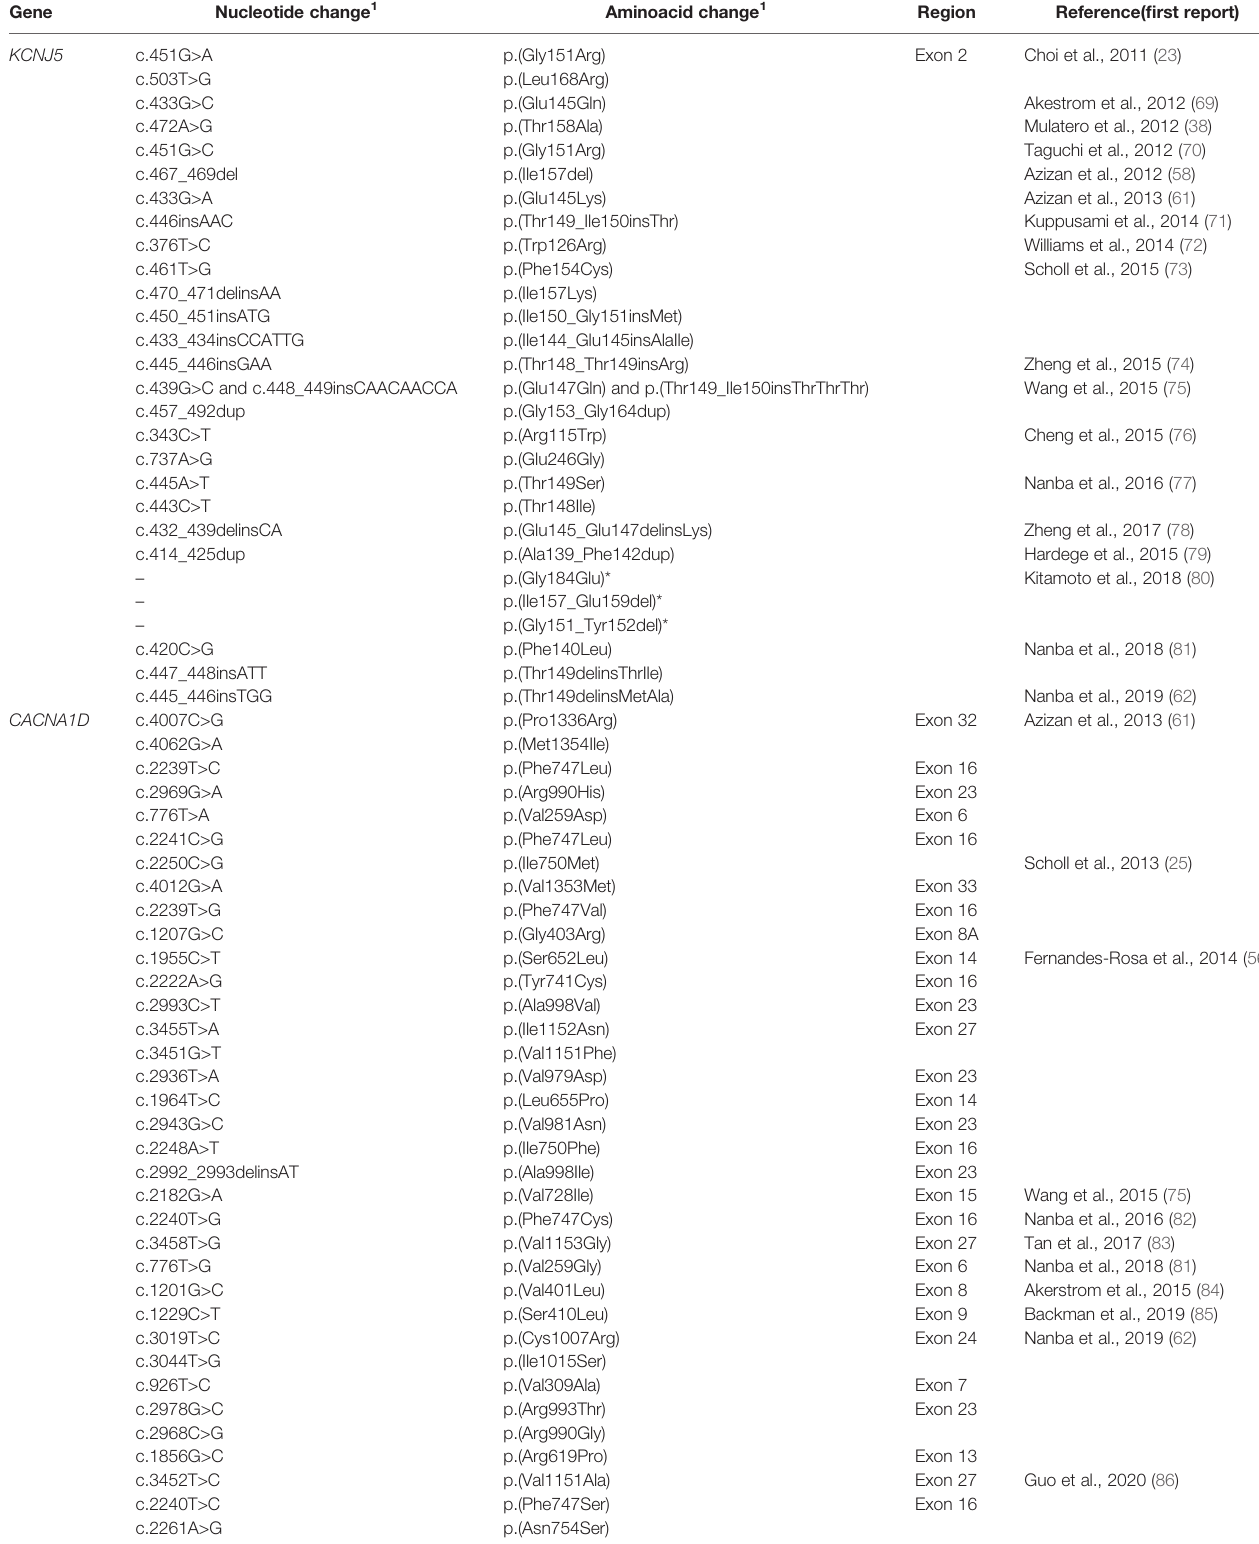
TABLE 4 | Somatic variants identi fi ed in adrenal lesions associated with unilateral primary